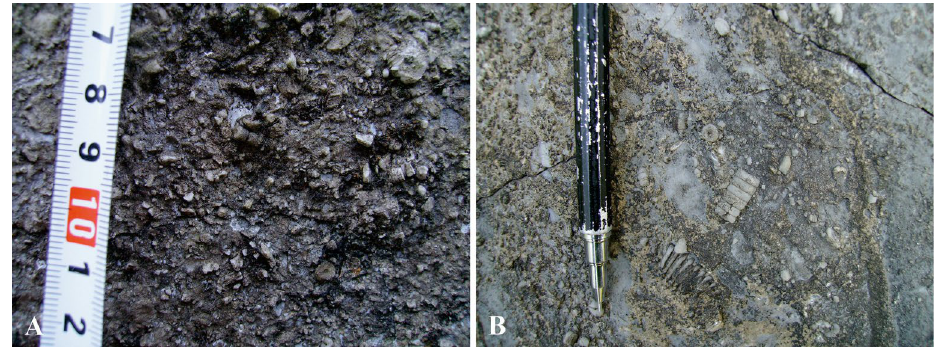
Figure 3. Clastic beaches in the Langping. Various clastic beaches developed in the study area. Diverse composition, fragmentation degree and sorting of the clast indicate different water conditions of formation. This figure is modified by the author from field photos with CorelDRAW (version 2022, and the URL link: https:// www. corel draw. com/